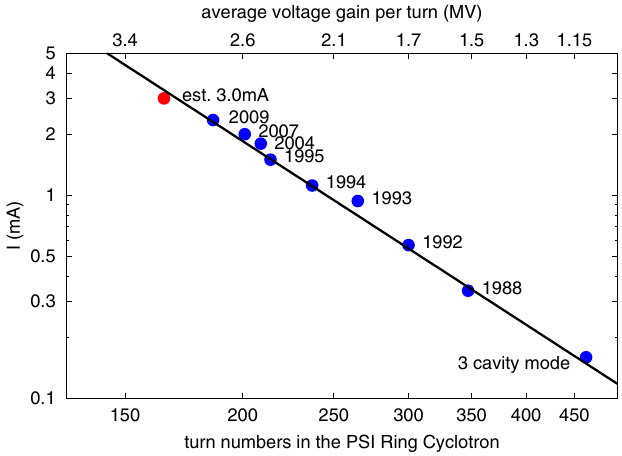
FIG. 10. Production beam current versus turn number over a span of 32 years of the PSI Ring cyclotron, in double logarithmic